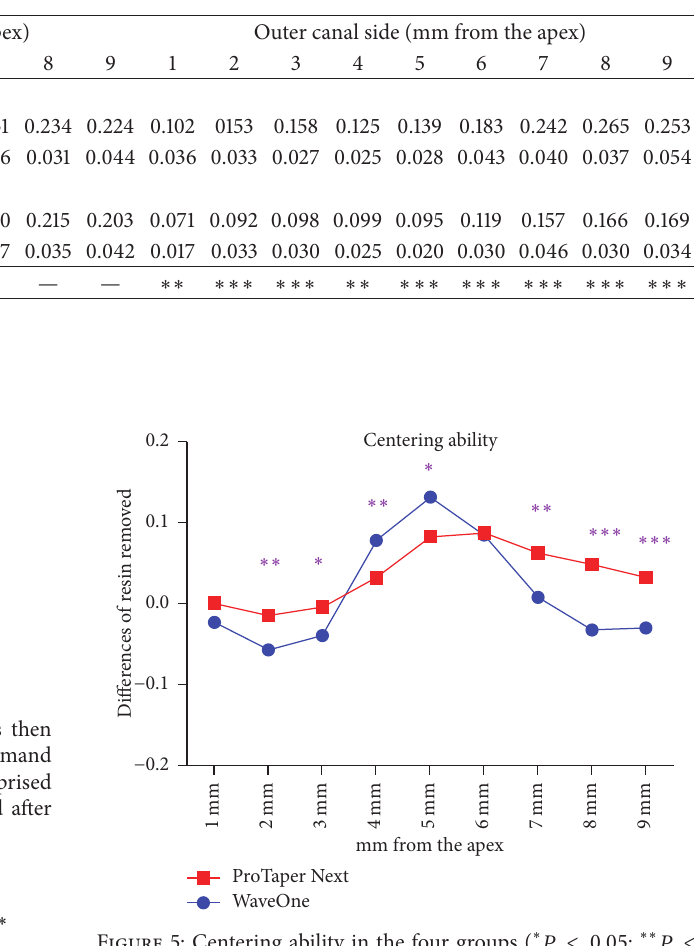
Figure 5: Centering ability in the four groups ( ∗ 𝑃 < 0.05 ; ∗∗ 𝑃 < 0.01 ; ∗∗∗ 𝑃 < 0.001